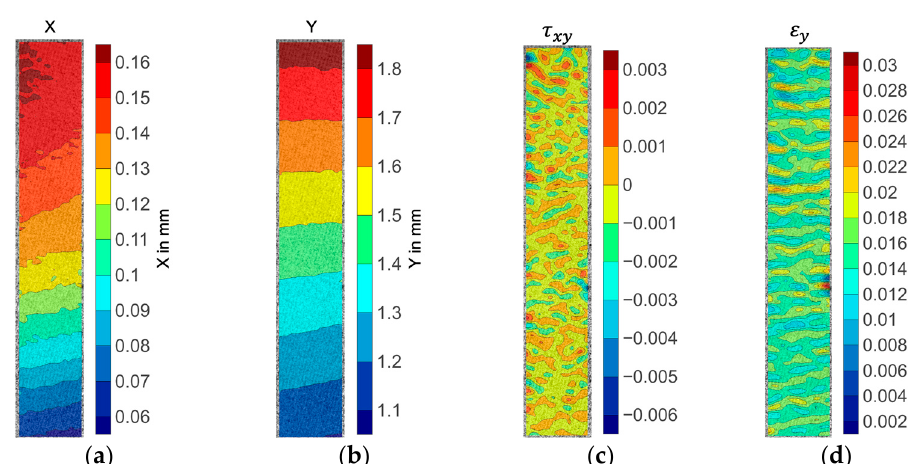
Figure 9. Representative DIC displacement and strain fields of 30° off-axis tension specimen: ( a ) X direction displacement fields; ( b ) Y direction displacement fields; ( c ) Shear strain field; ( d ) Tension strain field.